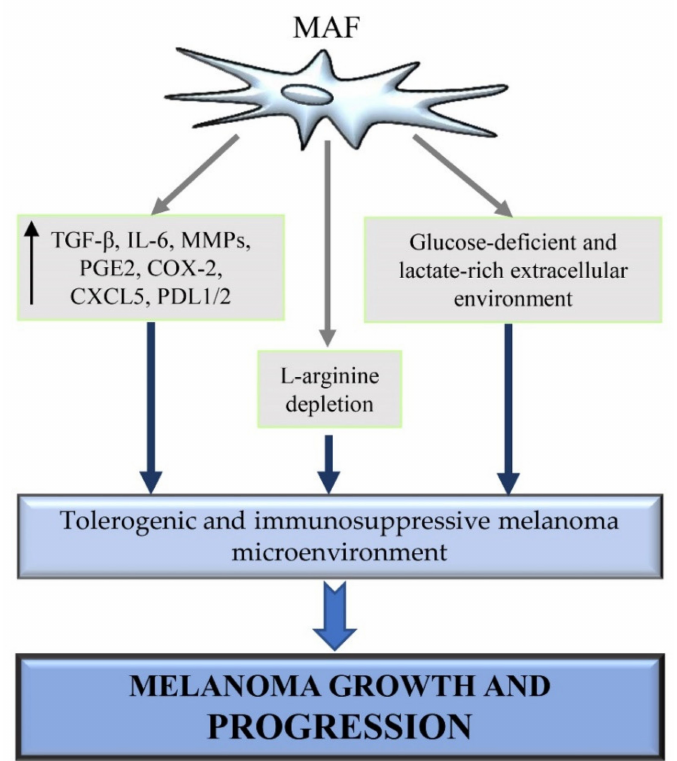
Figure 3. MAF immunomodulatory functions. MAFs generate an immunosuppressed melanoma microenvironment by multiple mechanisms. They increase the expression of various inflammatory and immunosuppressive factors, including TGF- β , IL-6, MMPs, PGE2, COX-2, CXCL5, and PDL1/2, which dramatically impair the anti-tumor activity of immune cells. Furthermore, MAFs alter the extracellular availability of lactate, glucose, and arginine, which are important immune-modulating metabolites involved in immune cell suppression or polarization toward a tumor-promoting pheno- type. Consequently, the generation of an immunosuppressive, glucose- and arginine-poor, lactate-rich melanoma microenvironment allows melanoma cells to evade immune surveillance and thus survive and proliferate safely in the tumor